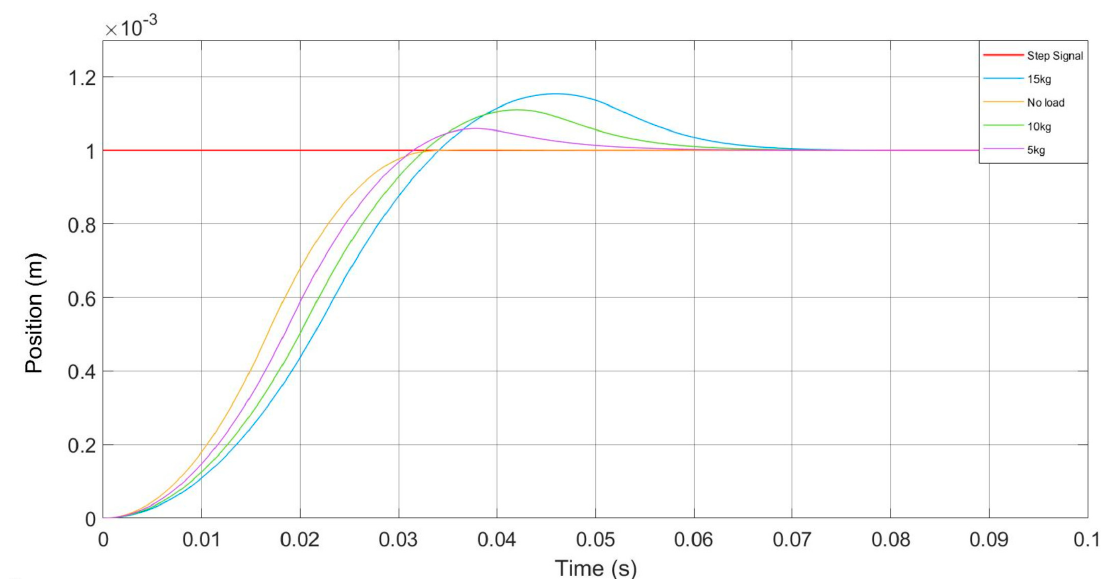
Figure 15. The system response time under different loads.